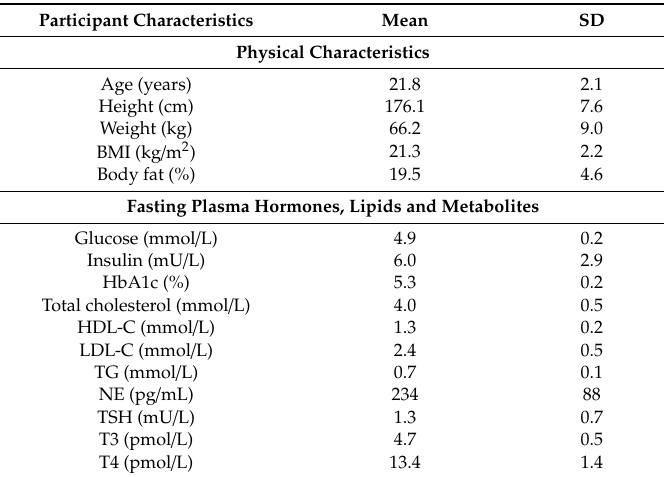
Table 1. Participant baseline characteristics ( n =